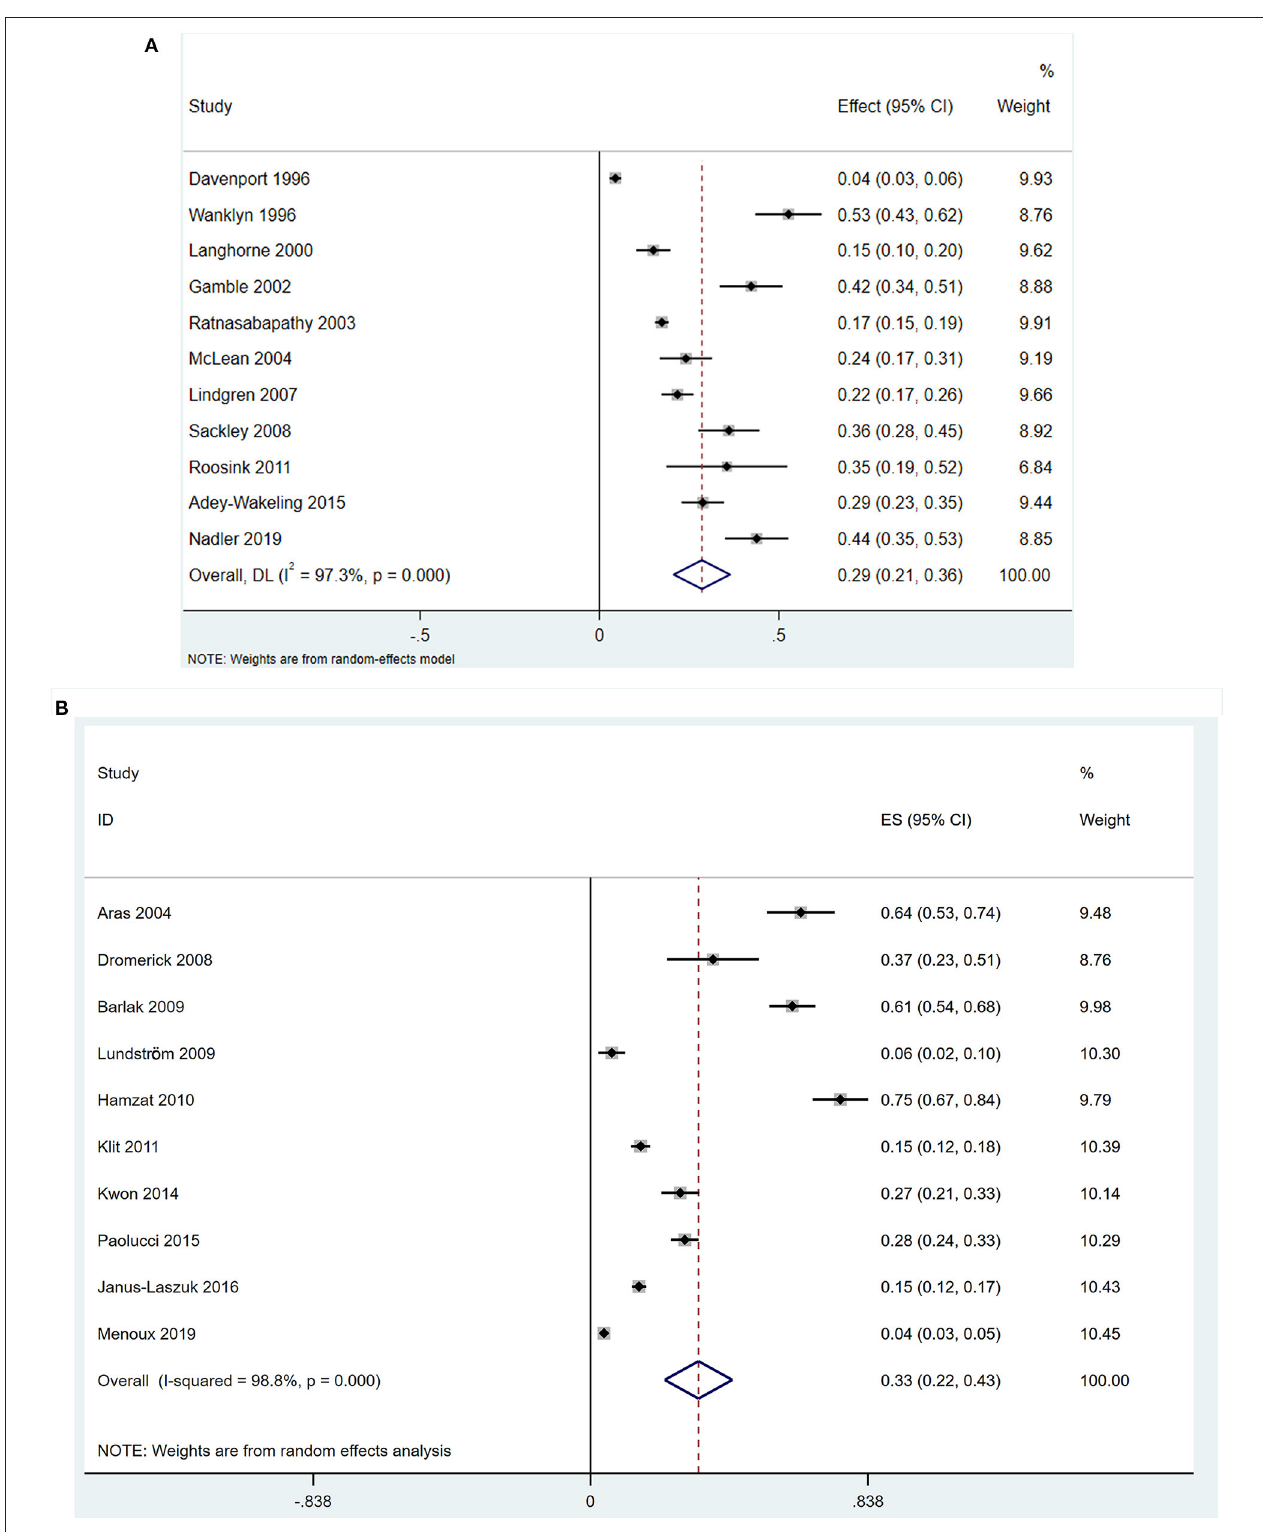
FIGURE 2 | Forest plots. (A) Forest plots of incidence of PSSP. CI, confidence interval; DL, DerSimonian-Laird; (B) Forest plots of prevalence of PSSP. ES, Effect Size.